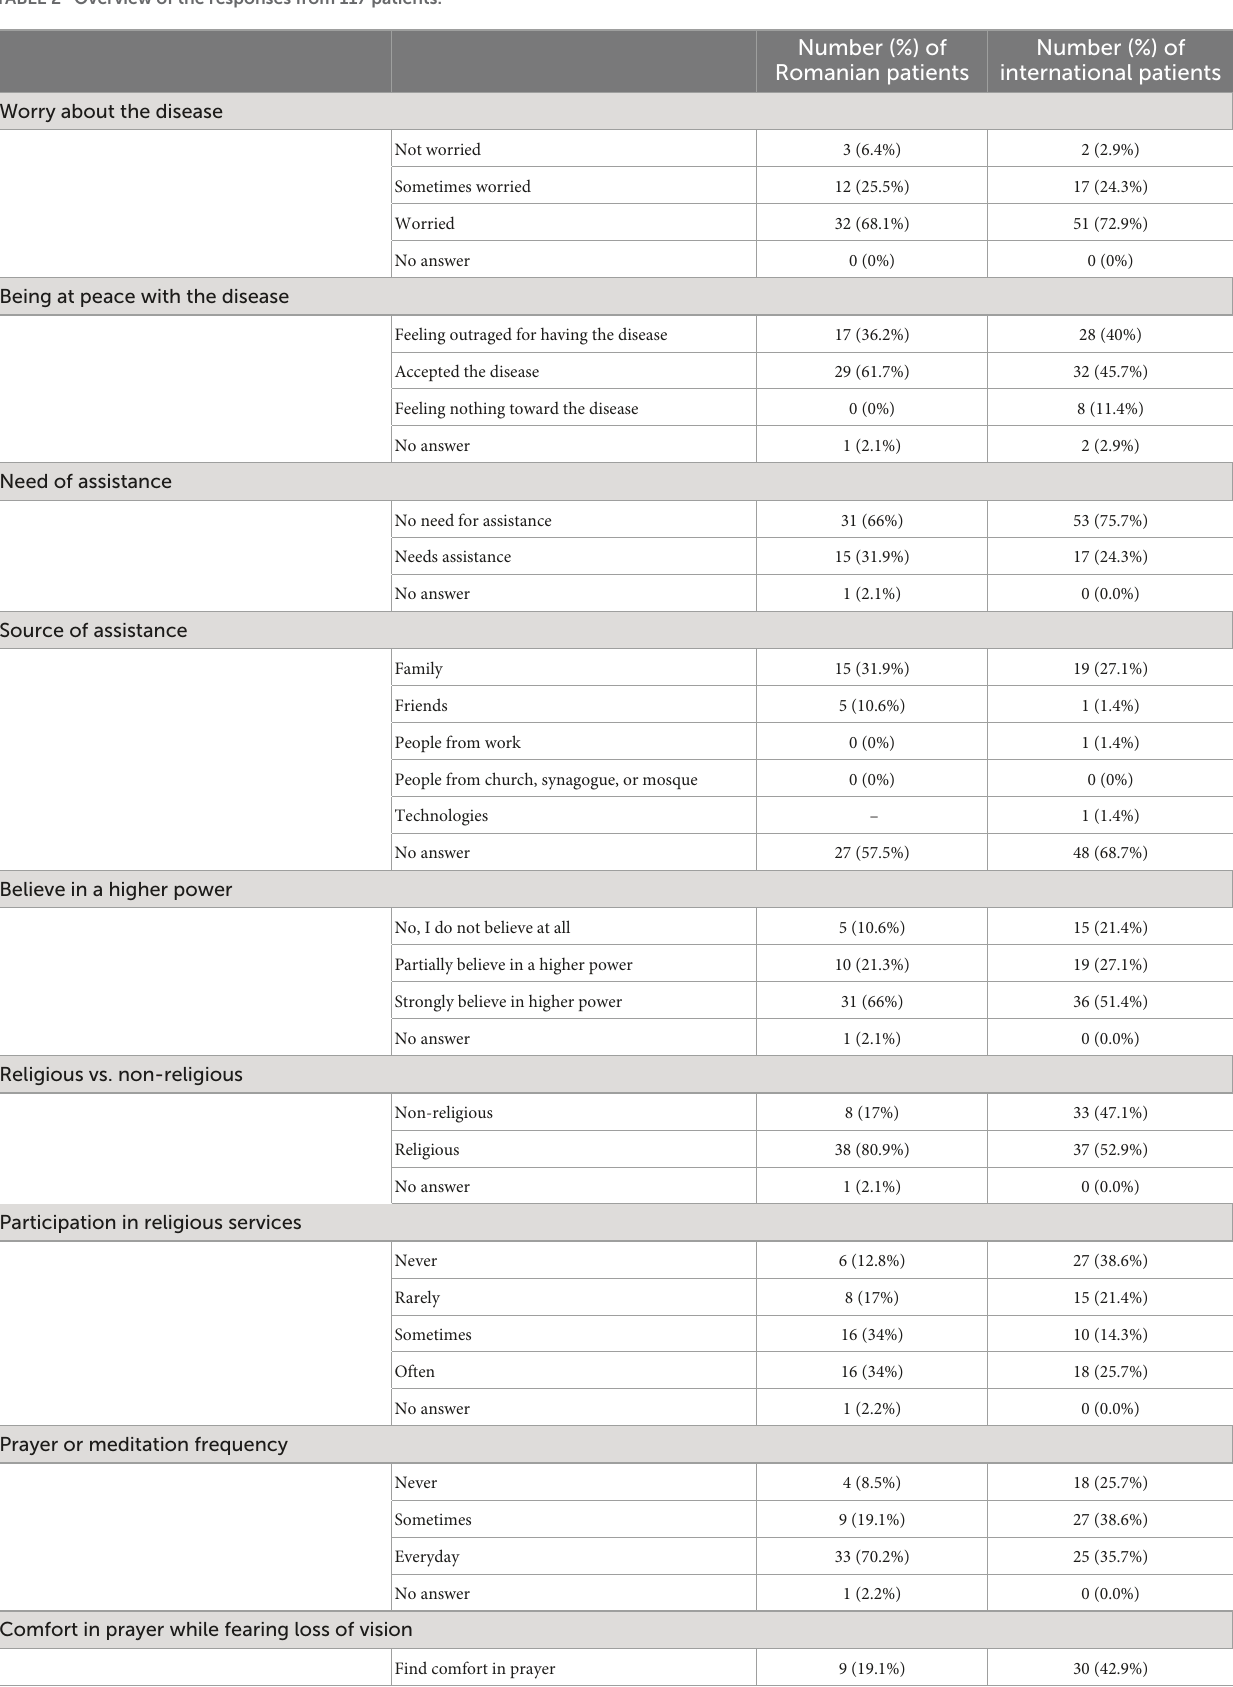
TABLE 2 Overview of the responses from 117